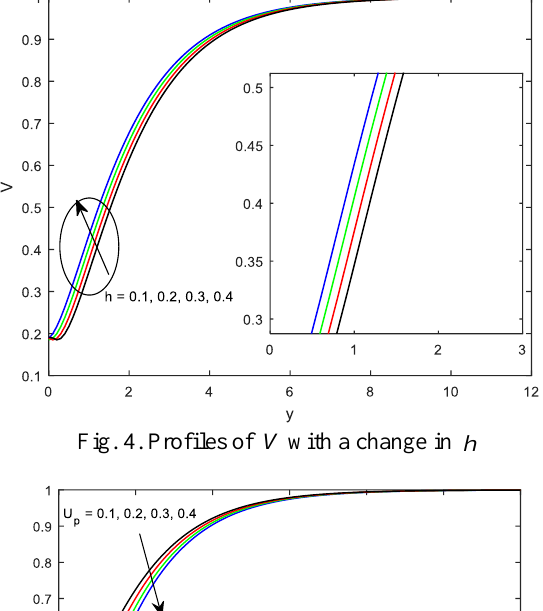
Fig. 4. Profiles of V with a change in h